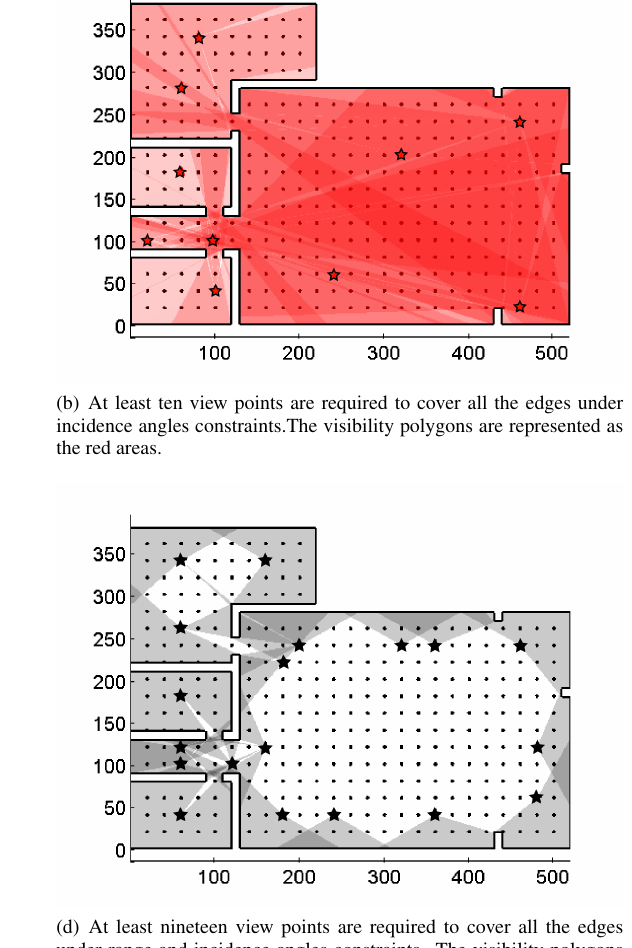
Figure 4: Visibility coverage of a complex room. 356 view points are used in the scene, depicted as black dots. Possible locations of the scanner that fulfil the visibility constraints are depicted as stars, with their visibility coverage area. The darker the visibility area, the more view points